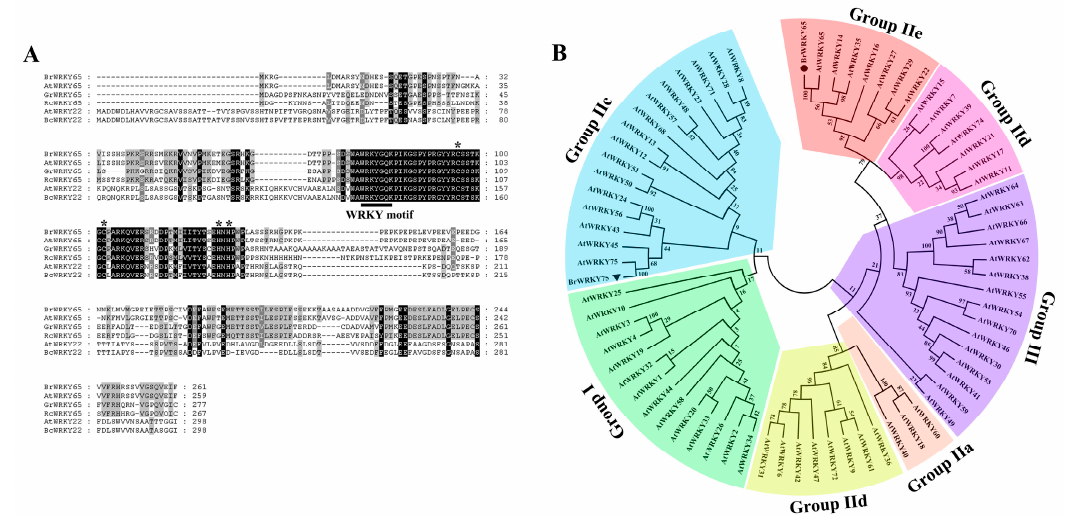
Figure 2. Bioinformatics analysis of BrWRKY65. ( A ) Multiple alignment of BrWRKY65 with Arabidopsis thaliana AtWRKY22 (XP_002872898.1) and AtWRKY65 (NP_174222.2), Pak-choi BcWRKY22 (NP_001288962.1), cotton GrWRKY65 (NP_001313892.1), and castor bean RcWRKY65 (XP_002522247.1). Black and gray shading indicate identical and similar amino acids respectively. The WRKY motif is underlined and the zinc-finger structures are indicated by asterisks; ( B ) A phylogenetic tree of Arabidopsis thaliana WRKYs and BrWRKY65. Three major groups and seven sub-families of WRKYs are presented in different colors. BrWRKY65, along with AtWRKY65, AtWRKY22, and AtWRKY35 were classified into Group IIe. MEGA5.0 was applied to construct the phylogenetic tree with default parameters.